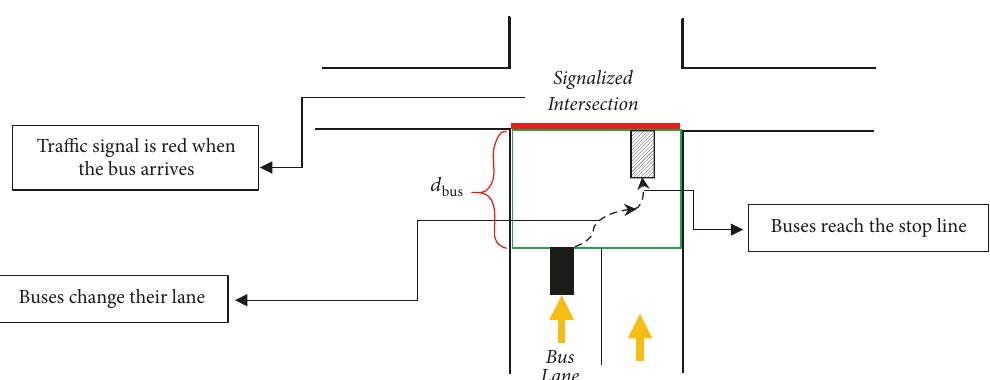
Figure 1: The buses’ approach for changing lane and reaching the stop line.